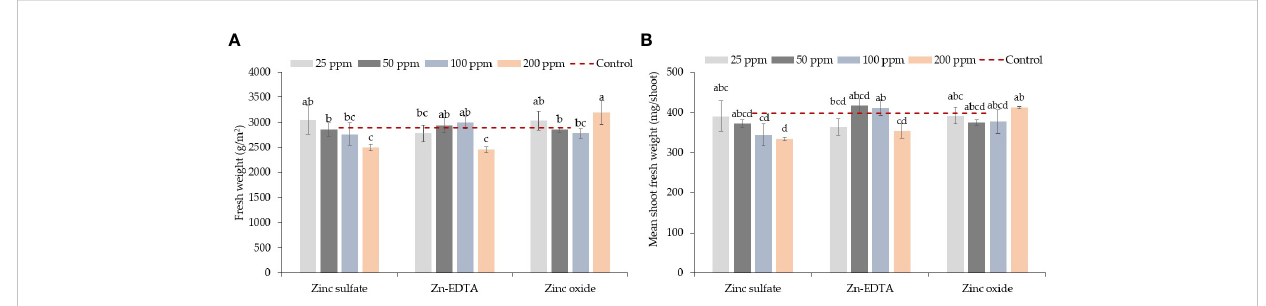
FIGURE 1 Zinc source and application rate interaction effect on pea shoot fresh weight (g/m 2 ) (A) and mean shoot fresh weight (mg/shoot) (B) . Vertical bars indicate average values and the standard error ( n = 3). Different letters indicate signi fi cant differences at p = 0.05 by the Fisher LSD test. The dashed line indicates the average value of the untreated control.